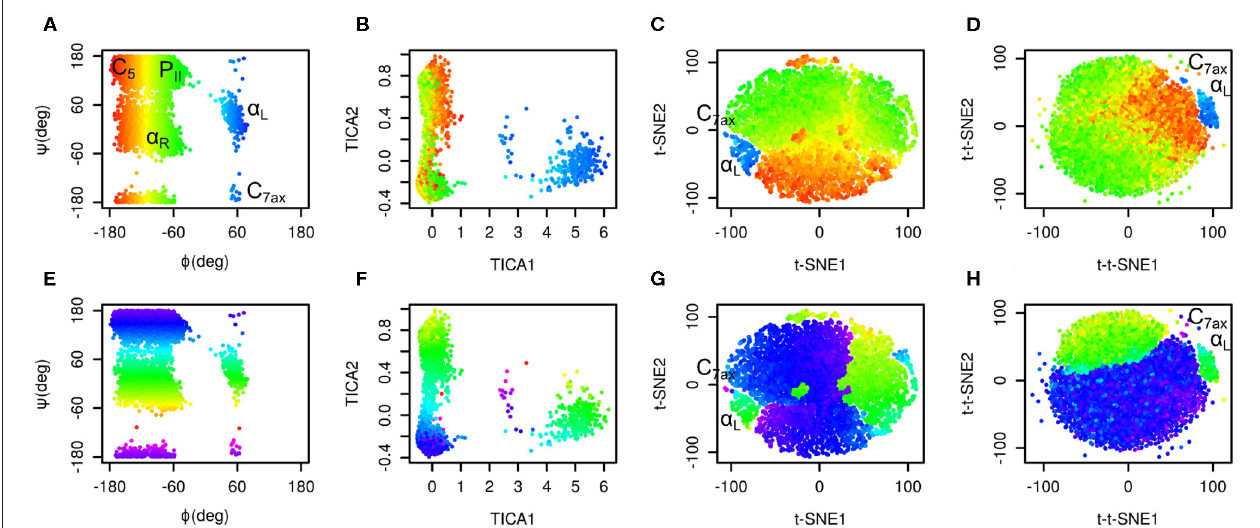
FIGURE 1 | Time-lagged t-SNE (t-t-SNE) applied on 200 ns simulation of alanine dipeptide in water. Conformations sampled in the simulations were projected into the space of Ramachandran torsions φ and ψ (A,E) , TICA coordinates (B,F) , t-SNE (C,G) and time-lagged t-SNE (D,H) . Points are colored by Ramachandran torsion φ (A–D) and ψ (E–H)